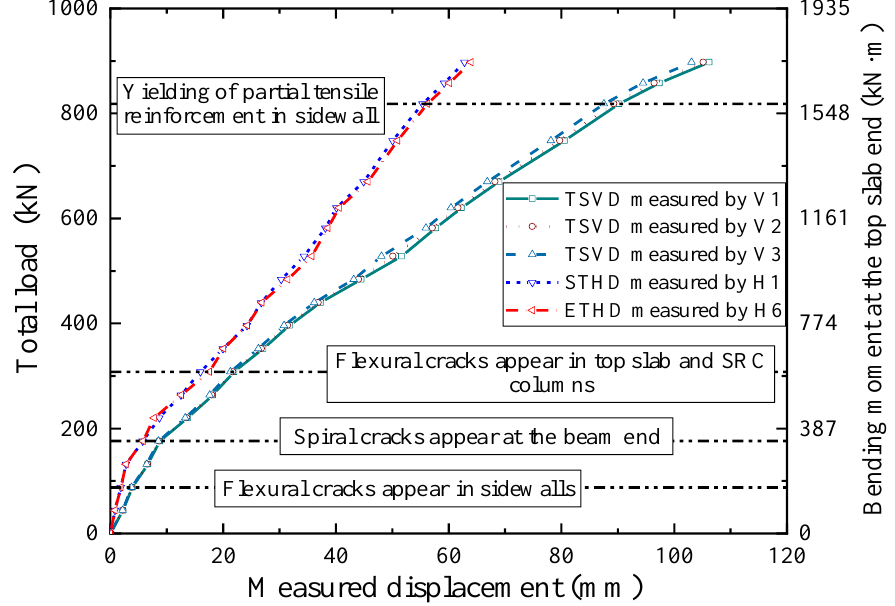
Figure 8. Load displacement curves for the specimen. The crack pattern of the test specimen at the yield stage of all tensile reinforcements in the sidewalls is illustrated in Figure 9. As shown in the back view, the first flexural crack was observed on the tension side of the sidewalls when the applied load reached 88 kN, corresponding to a bending moment of 170.3 kN·m at the end of the top slab. The load level at this stage was approximately 0.1 P y . Here, P y is the maximum load corresponding to the load at which all tensile reinforcements in the sidewalls yielded. Subsequently, the number of flexural cracks along the vertical direction of the sidewalls gradually increased, and the crack width increased as the applied load increased. As the applied load increased, the horizontal cracks appearing on the sidewalls further increased in the SRC column section. This further indicates the effectiveness of the connection between the SRC column and sidewalls in transferring stress.